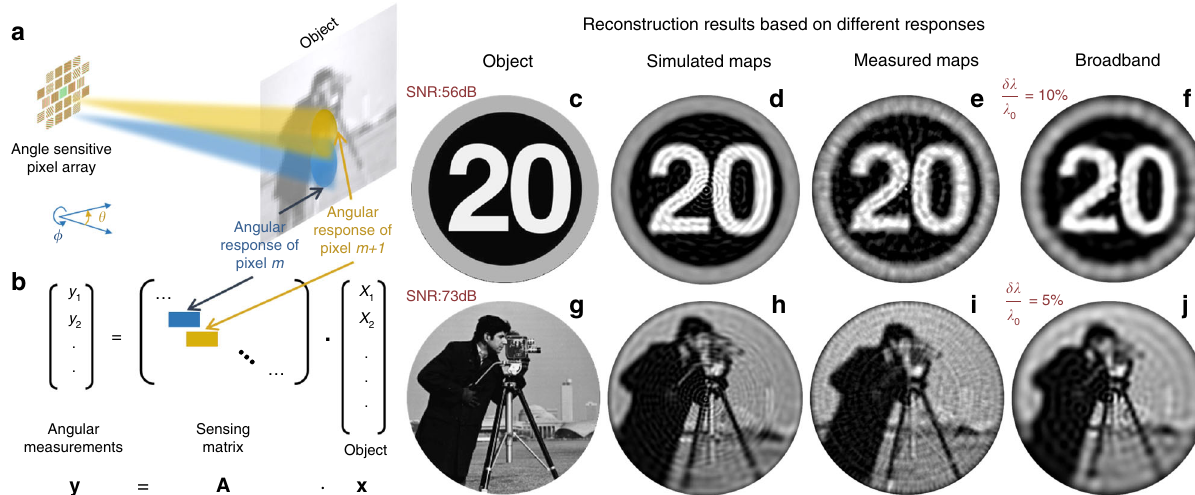
Fig. 4 Data acquisition and image reconstruction. a Schematic illustration of the imaging geometry. Each pixel integrates the incident light intensity from different directions according to its angular response. b Image-formation model. The pixel-array measurement is related to the object by a linear equation y = Ax , where the sensing matrix A contains the angular responses of all pixels. c – f Representative object ( c ) and corresponding image reconstruction results at SNR = 56 dB ( d – f ). g – j Example of a more complex object ( g ) and corresponding image reconstruction results at SNR = 73 dB ( h – j ). The original cameraman image ( g ) is used with permission from its copyright owner (Massachusetts Institute of Technology). The images of d , h are based on the simulated responsivity patterns of Fig. 2 with a 6240-pixel array at λ 0 = 1550 nm. The images of e and i are based on the experimental responsivity patterns of Fig. 3 with a 5280-pixel array at λ 0 = 1550 nm. The images of f and j are based on the simulated patterns under broadband illumination with bandwidth δλ / λ 0 = 10 % ( f ) and 5 % ( j ). The image reconstruction algorithm is made publicly available